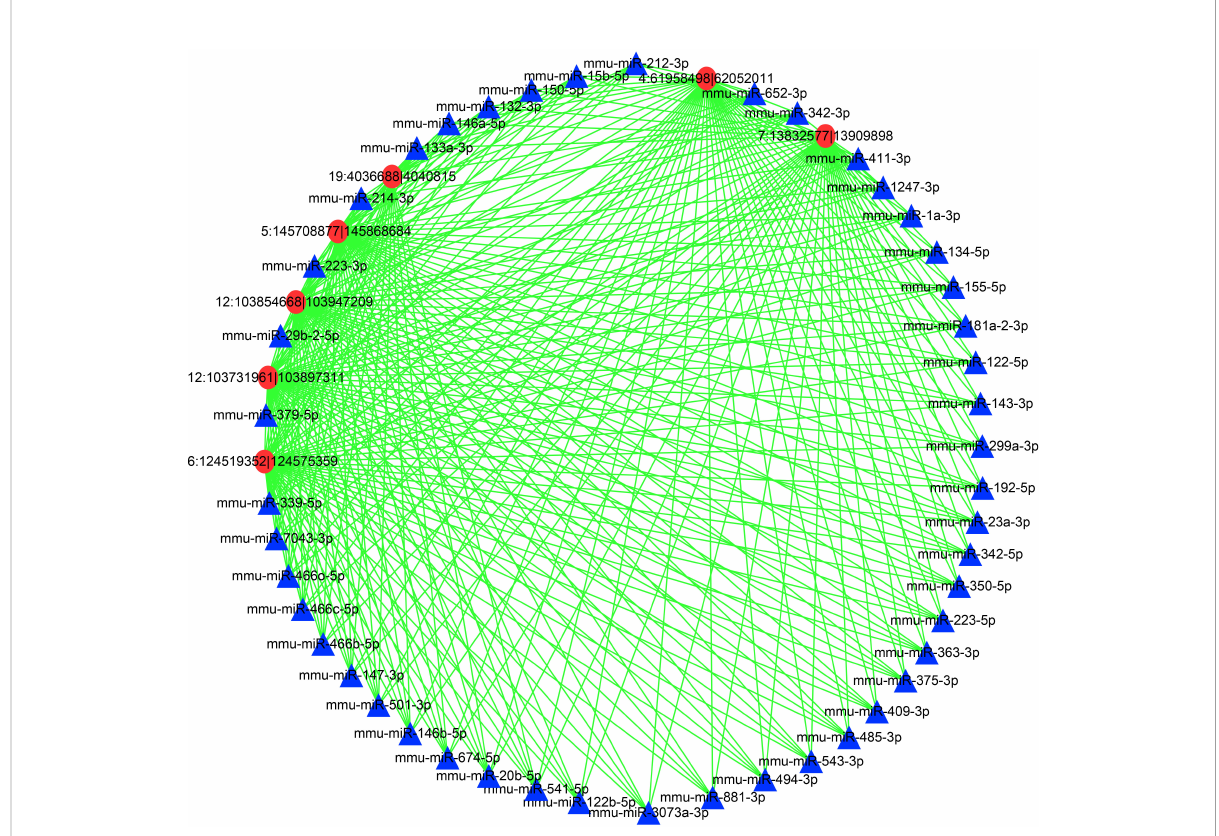
FIGURE 5 A network of the commonly DEcircRNAs with their associate DEmiRNAs. Different colors show different RNA, with red for DEcircRNAs and blue for